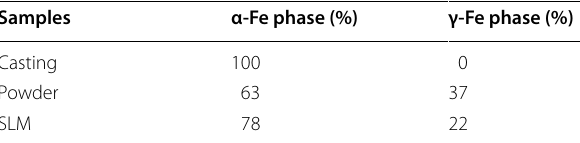
Table 2 Volume fraction of the detected phase